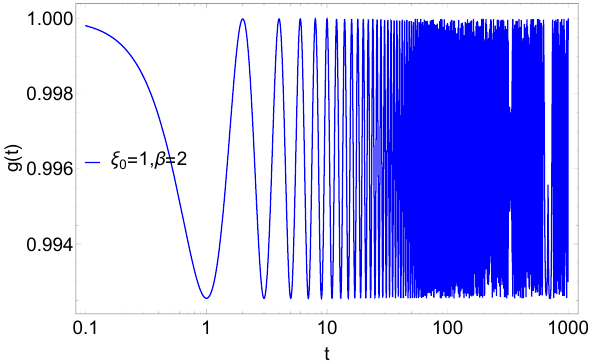
Figure 9. SFF for 2 d Rindler normal modes with ξ 0 = 1 and β = 2